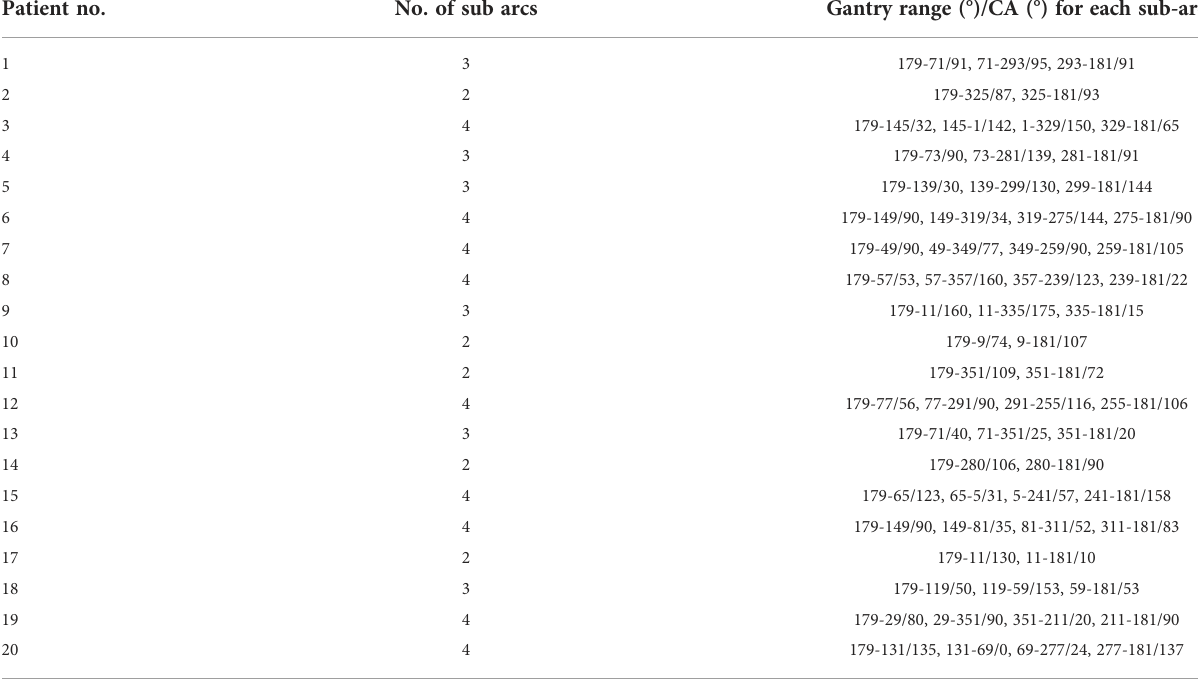
TABLE 2 Optimized sub-arc segmentation and related collimator angles in one full arc based on the SACAO method for 20 patients. Patient